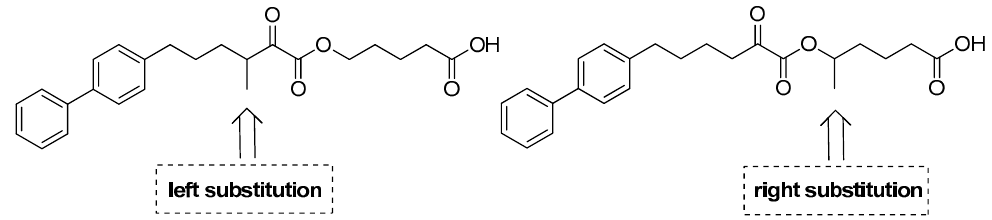
Figure 2. Design of α -methyl derivatives of GK452 inhibitor of GIVA cPLA 2 .